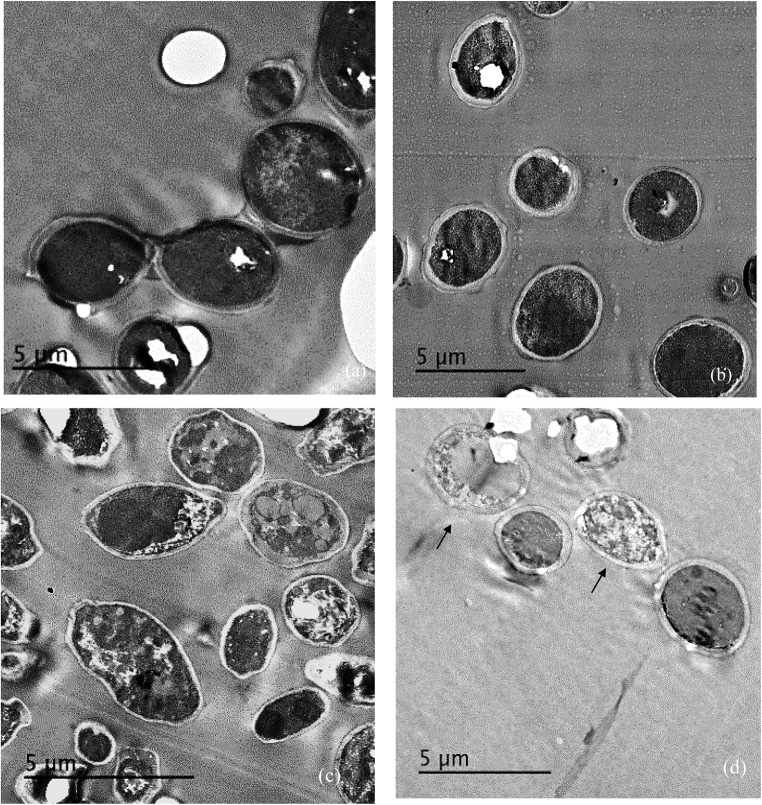
Transmission electron microscope (TEM) images of treated and untreated Candida albicans displaying (a) a normal morphology with intact cell walls and dense cytoplasm, (b) urea- treated cells showing some irregularities in the cell wall but the cytoplasm remained dense, (c) miconazole-treated cells with less dense cytoplasm, (d) cells treated with a combination of miconazole/urea showing disrupted cytoplasm as pointed by arrows (1200×).